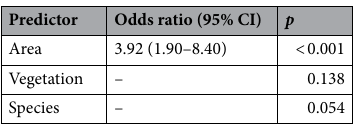
Table 2. Risk factors for T. gondii infection.